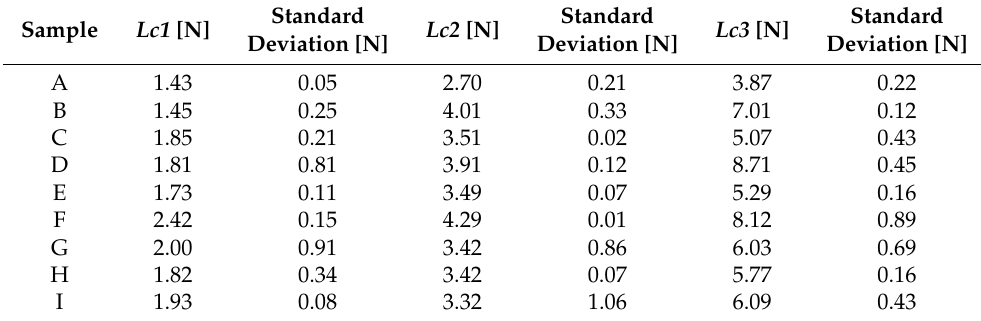
Figure 9. Critical loads determined for layers: ( a ) Sample A; ( b ) Sample B ( c ) Sample C; ( d ) Sample D; ( e ) Sample E; ( f ) Sample F; ( g ) Sample G; ( h ) Sample H; ( i ) Sample I; Lc1 —Hertz cracks; Lc2 —cohesive cracks; Lc3 —adhesive cracks and complete damage of layer. Table 6. Critical loads determined for the tested